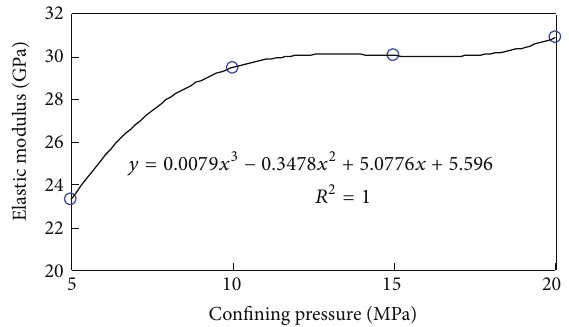
Figure 10: Relationship between elastic modulus and confining pressure under 300 ∘ C.